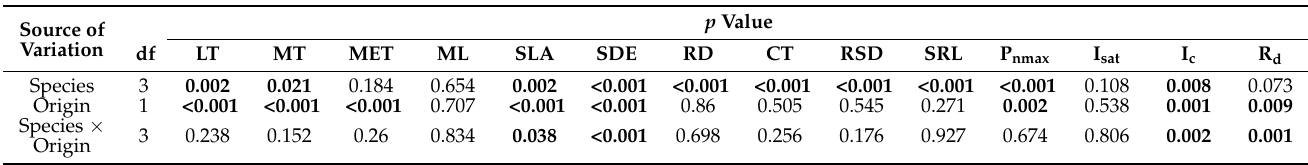
Table 4. ANOVA of the effects of species, origin, and their interaction on the key morphological, anatomical and photosynthesis traits.